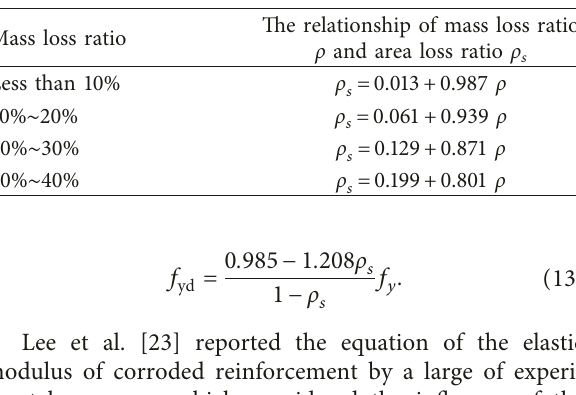
Table 1: The relationship of area loss and mass loss.